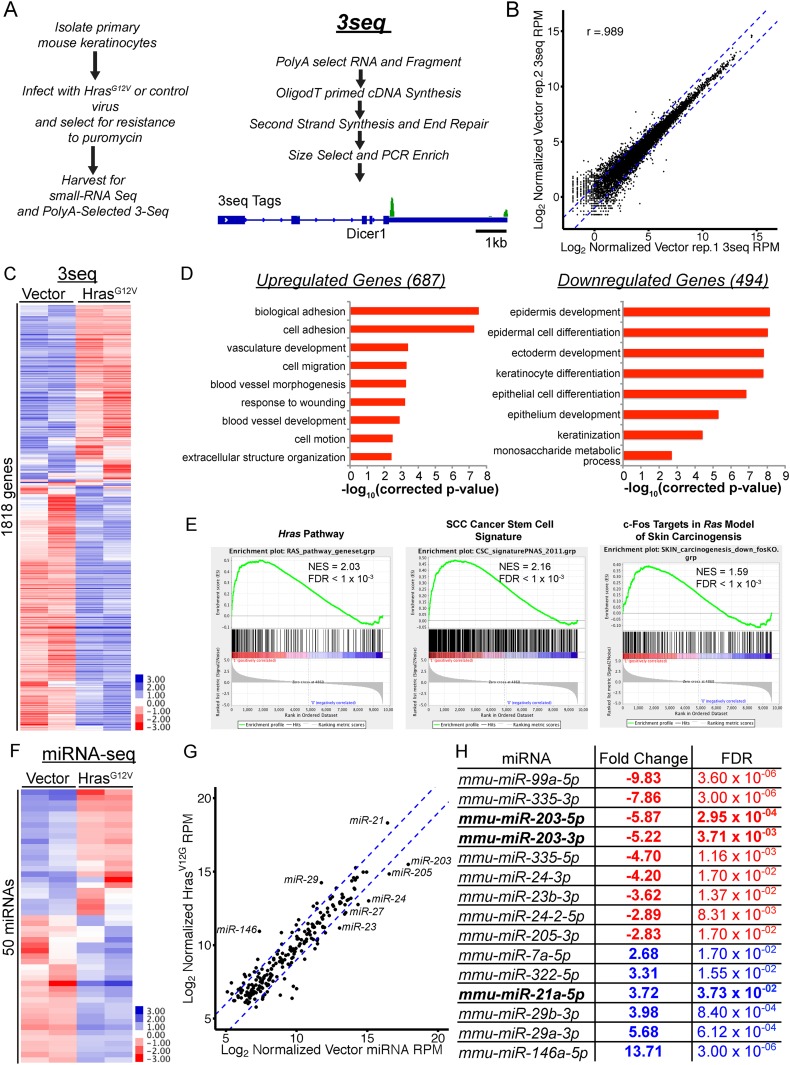
Genome-wide profiling of the oncogenic HrasG12V-transformed miRNA and mRNA transcriptome in primary keratinocytes.(A) Schematic of experimental approach to identify deregulated mRNA and miRNA networks driven by oncogenic HrasG12V using small-RNA Seq and 3Seq. The 3seq library preparation allows quantitative definition of poly-A+ RNA 3′ends and expression levels. (B) 3Seq reproducibly detects mRNA expression levels over 4 orders of magnitude. Pearson correlation coefficient displayed (C) unsupervised hierarchical clustering of log-transformed mean-centered mRNA expression levels for all transcripts deregulated twofold by oncogenic HrasG12V (n = 2 libraries per condition) (D) Gene Ontology analysis of transcripts up and downregulated by HrasG12V (twofold change FDR <0.05) indicates enrichment for migratory and angiogenic processes, and suppression of keratinocyte differentiation. (E) GSEA analysis of selected genesets relevant to skin carcinogenesis. (F) Unsupervised hierarchical clustering of log-transformed mean-centered miRNA expression levels for all transcripts deregulated twofold by oncogenic HrasG12V (n = 2 libraries per condition) (G, H) Abundant miRNAs such as miR-203, miR-205, and miR-21 are strongly deregulated by oncogenic Ras.DOI:
http://dx.doi.org/10.7554/eLife.07004.00310.7554/eLife.07004.004Figure 1—source data 1.Log2 fold changes for transcripts up or down regulated twofold with FDR <0.05 in HrasG12V-transformed keratinocytes.